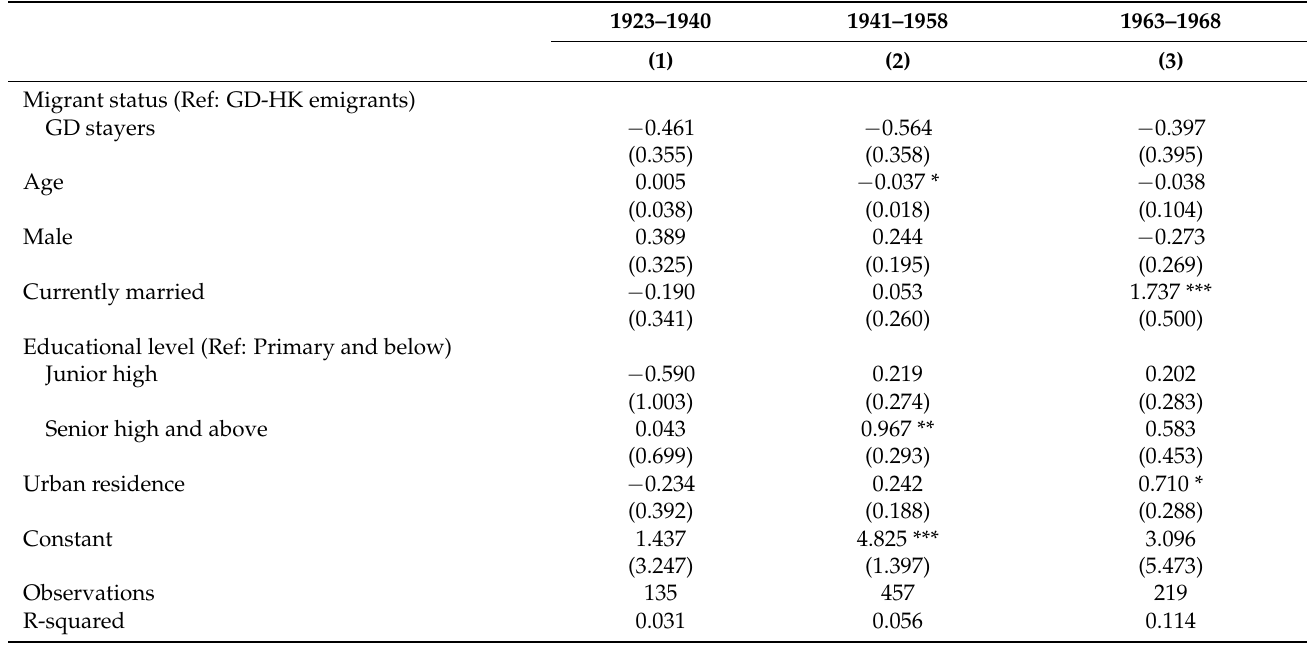
Table 3. OLS regressions of delayed word recall for different birth cohorts (the migrant-stayer comparisons